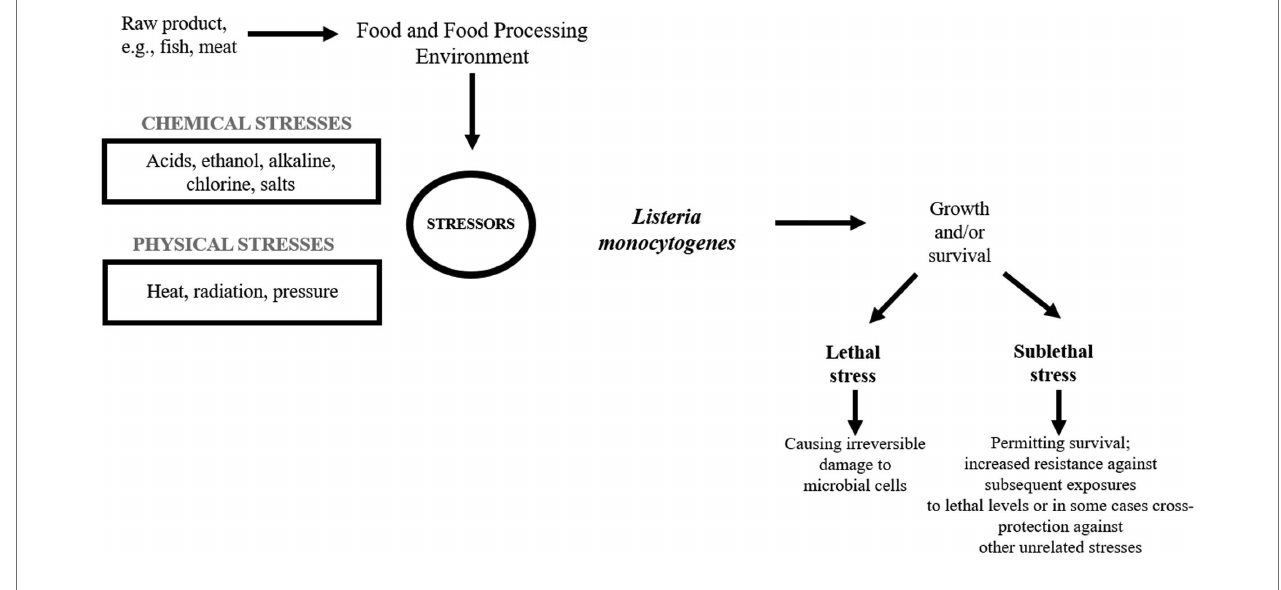
FIGURE 1 | Listeria monocytogenes in the food processing